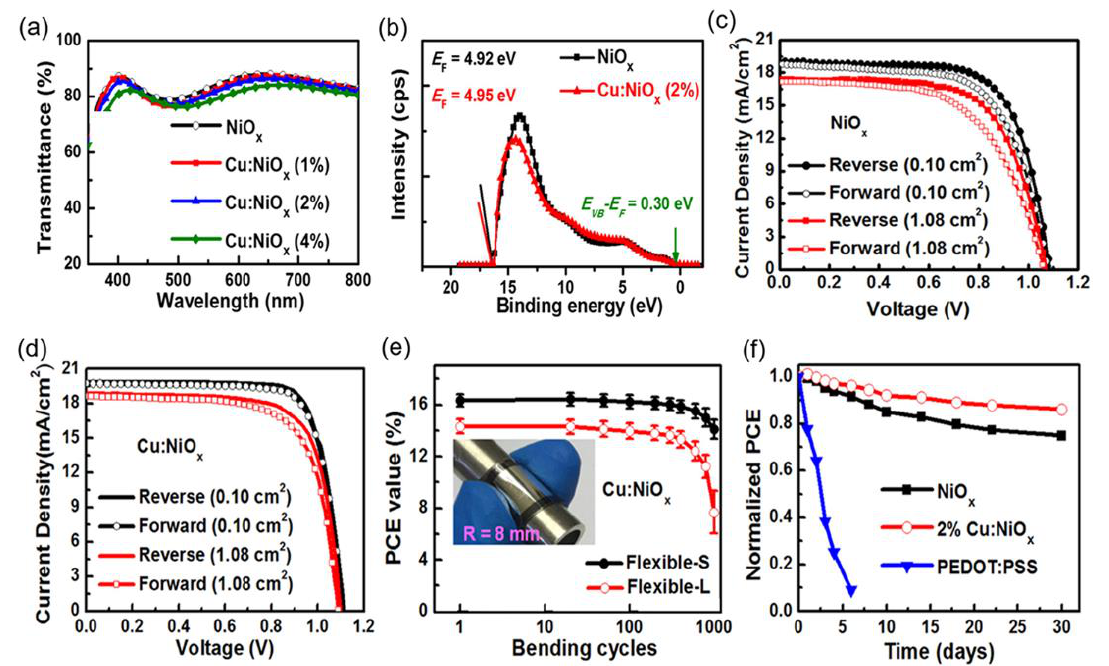
Figure 6. ( a ) Optical transmission spectroscopy of NiO x and various Cu doped NiO x films deposited on the quartz glass; ( b ) Ultraviolet photoelectron spectroscopy (UPS) spectra of NiO x and 2 mol.% Cu doped NiO x films; J–V curves of flexible PSCs with ( c ) pristine NiO x and ( d ) 2 mol.% Cu doped NiO x as HTLs under forward and reverse scan directions; ( e ) the PCE stability of flexible PSCs with 2 mol.% Cu doped NiO x HTL as a function of the number of bending cycles; ( f ) ambient stability of PSCs with NiO x , 2 mol.% Cu doped NiO x and PEDOT:PSS as HTLs. Reproduced from [63], with permission from the ACS Applied Materials & Interfaces, 2017.